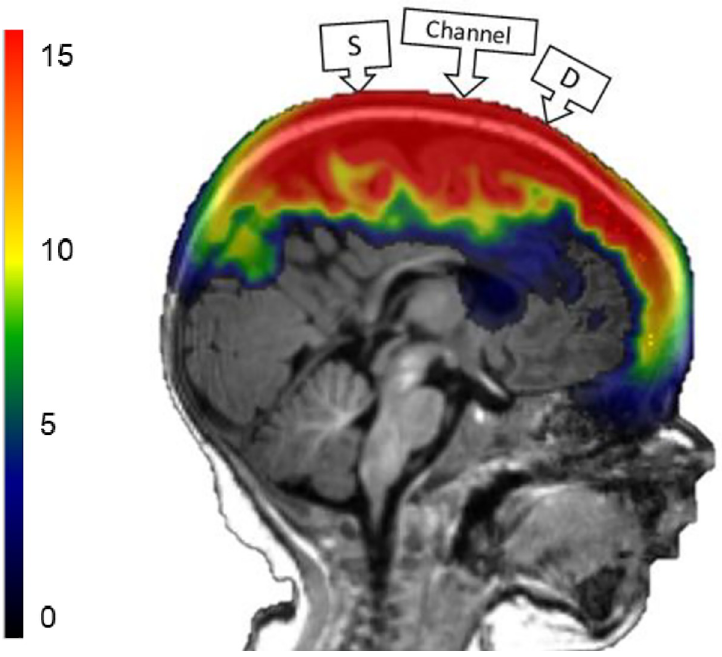
Fig 3. Source-detector (S-D) channel DOT fluence distribution. Monte Carlo photon migration simulations were used to estimate fluence distributions. The red area represents greater fluence.